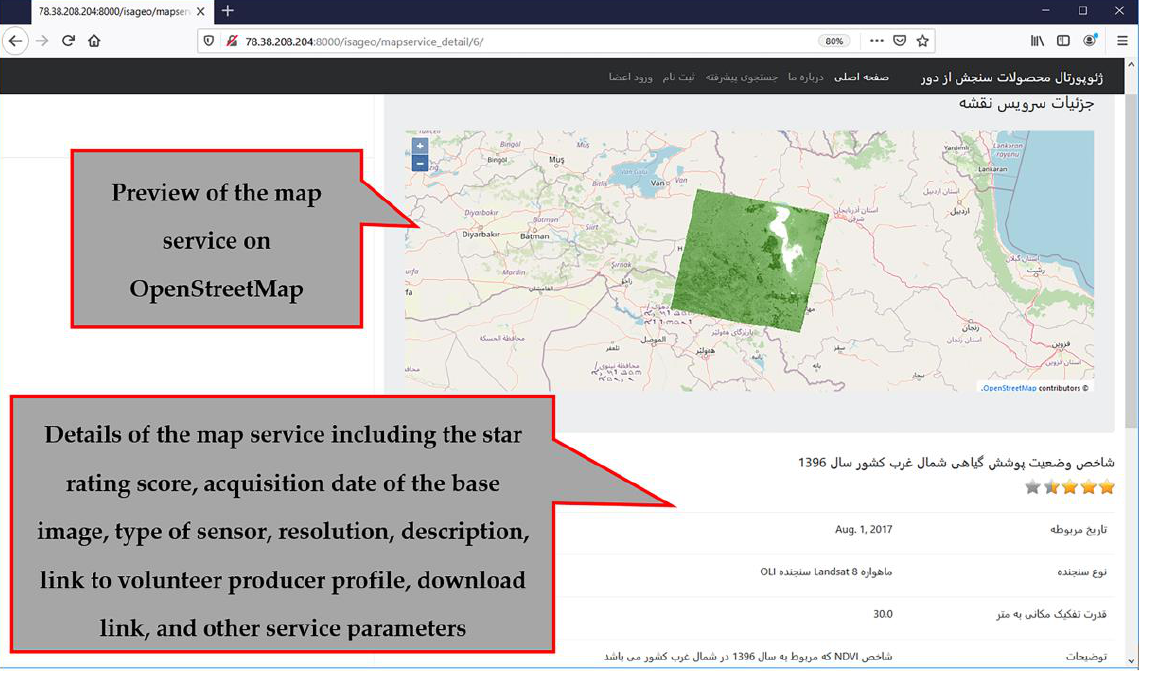
Figure 8. Advanced search for finding an Earth observation (EO) product service based on location boundary on the map and metadata such as category, title, a term in the description, and time span; the result includes the name of map service, a snippet of the description, the thumbnail, and a link to details.